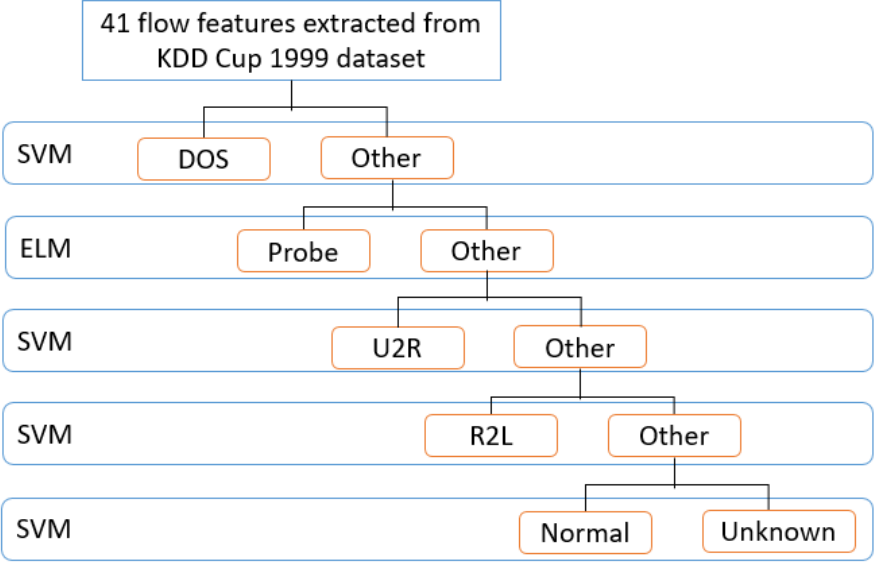
Figure 4. Multi-level hybrid IDS via class imbalance with deep learning.